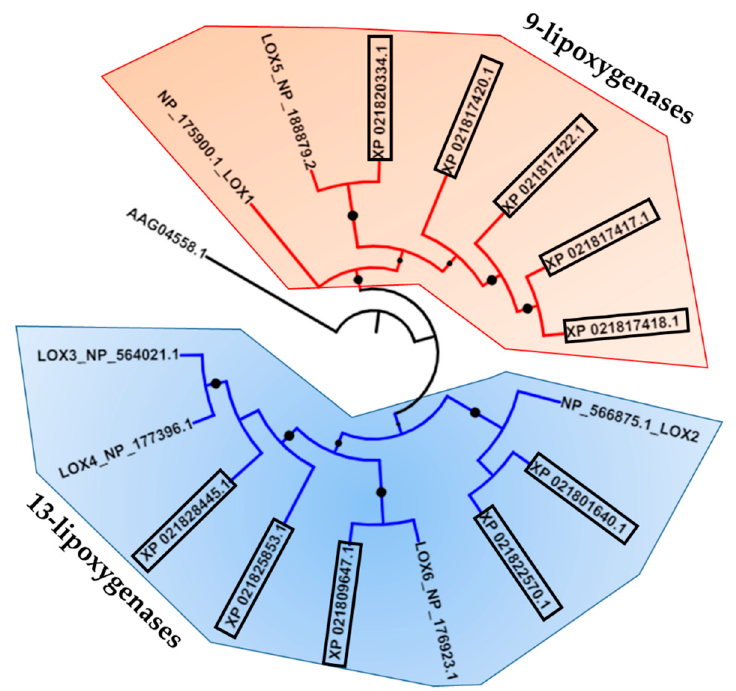
Figure 1. Maximum likelihood phylogenetic tree (number of bootstraps in ultrafast mode: 1000) of di ff erent LOX protein’s full length sequences from thale cress and P. avium (boxed). Accession numbers from thale cress are NP_175900.1, NP_188879.2, NP_566875.1, NP_176923.1, NP_177396.1, NP_564021.1. All the other accessions in the tree are sequences from P. avium (see Table 1). Bootstrap values comprised of between 0.8 and 1 are displayed (the bigger the circle, the higher the bootstrap value). The tree was